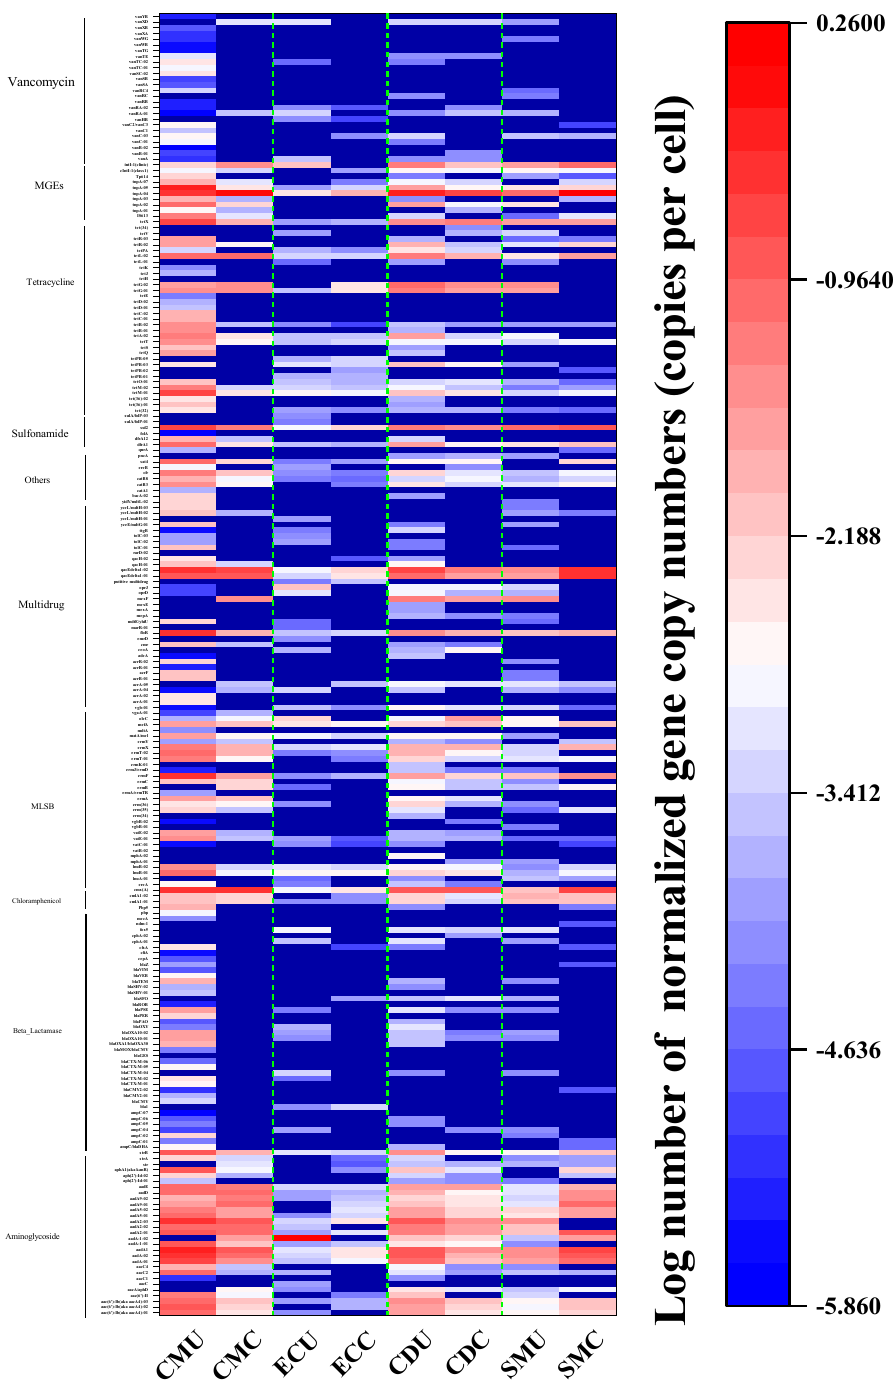
Figure 8. Heatmap analysis of ARGs in organic fertilizer samples. The vertical axis lists the detected ARGs found in this study. The order of the genes was based on their similarity abundance.